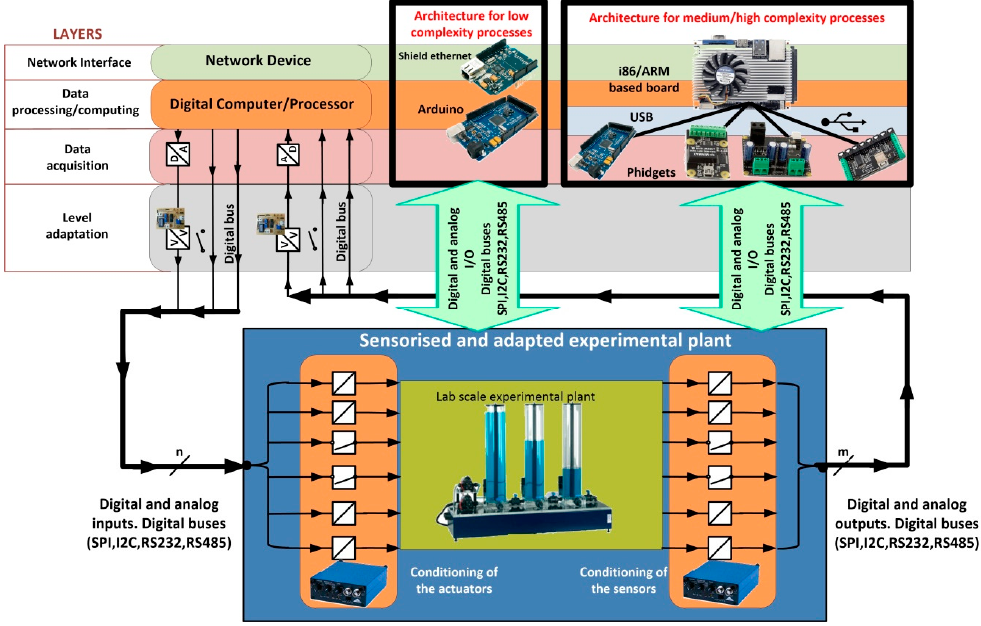
Figure 3. General diagram proposed to implement the convergence subsystem.